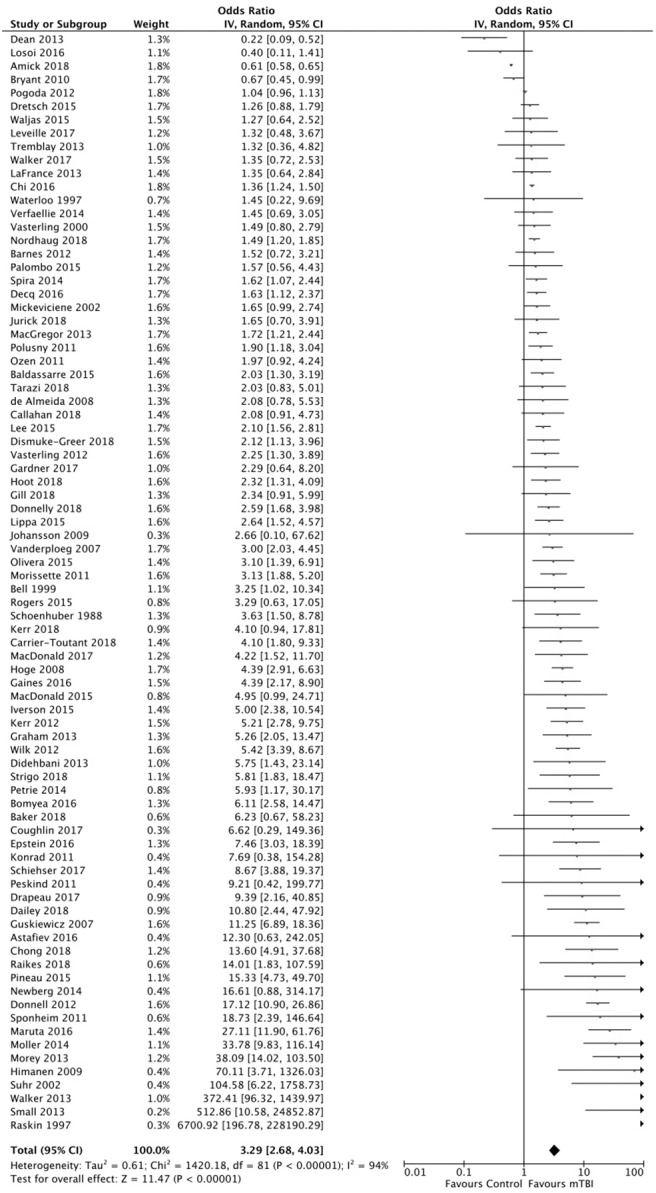
Forest plot representing pooled data from 82 studies reporting depression assessments at least 6 months after mild traumatic brain injuiry (mTBI). In each study, data for mTBI patient groups were compared with control groups for odds of depression. OR, odds ratio. Risk of bias was assessed using the SIGN methodological checklist.